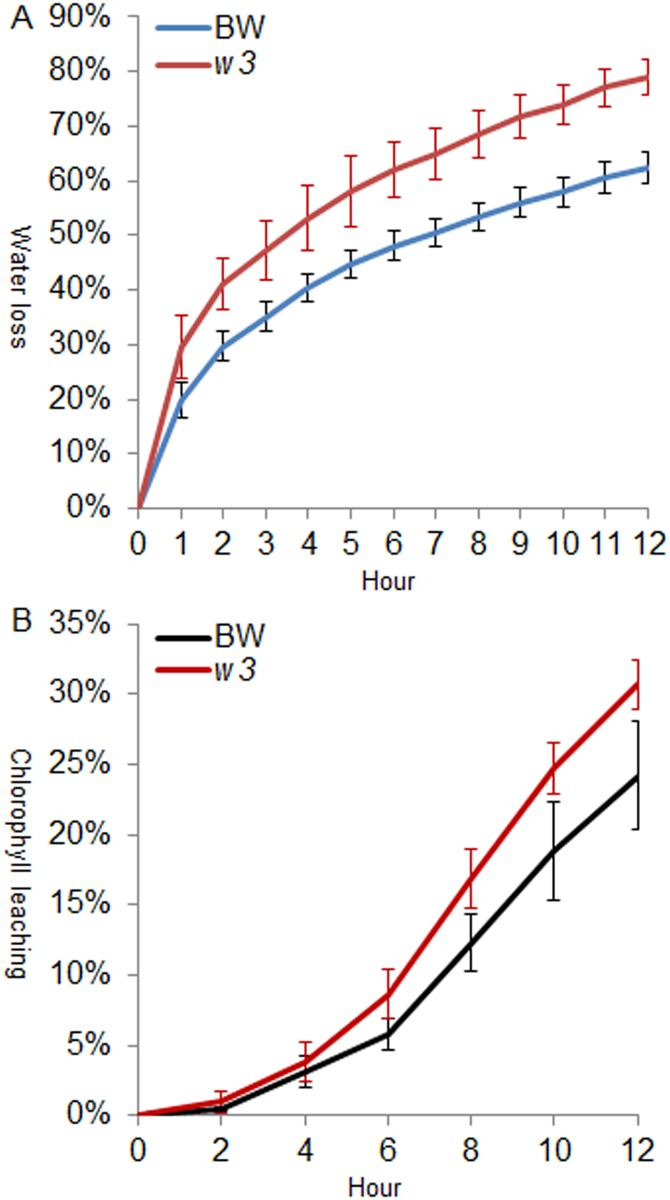
Analysis of cuticle permeability of BW and w3 mutant.Cuticle permeability was evaluated by air drying at room temperature (A) and by chlorophyll leaching in 80% ethanol (B). The numbers on the x-axes represent hours of treatment. Water loss or chlorophyll leaching at each time point is represented on the y-axes as percentages of the total water content or total chlorophyll content in the tissue. Measurements taken from six individuals were averaged.